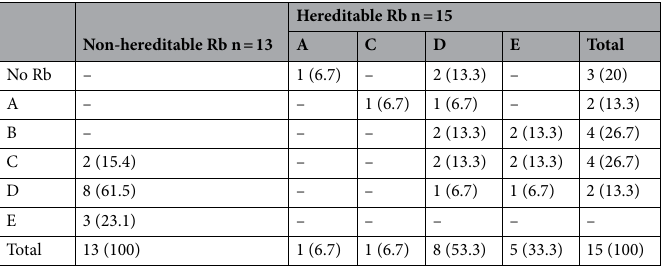
Table 3. Classification of non-hereditable and hereditable retinoblastoma according to International classification of Retinoblastoma (ICRB) 8 .